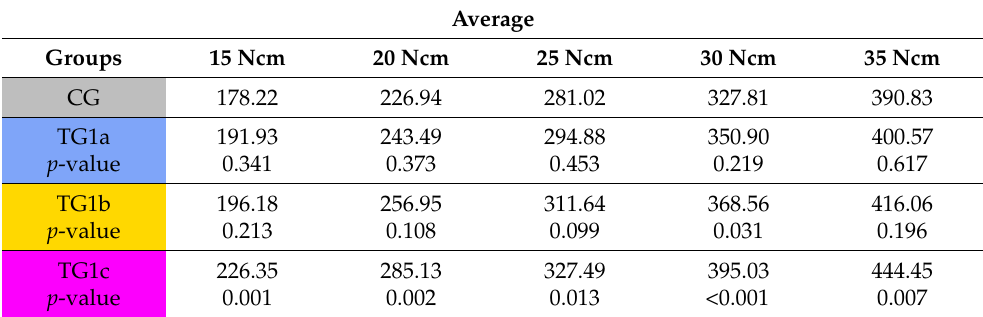
Table 2. Average preload forces based on group and tightening torque. p -values refer to the compari- son with the control croup